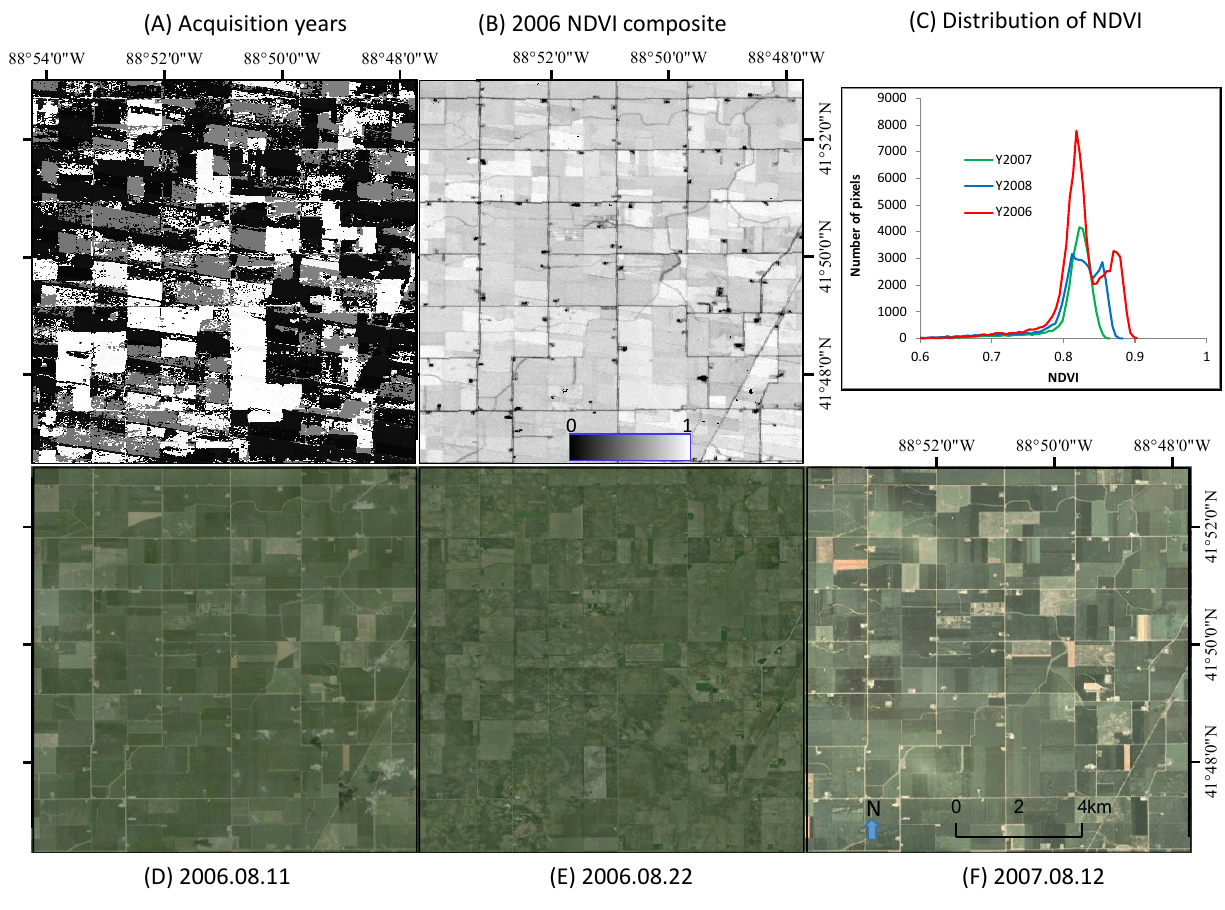
Figure 8. Acquisition years and NDVI values in the 2006 composite in a subregion in the Chicago area. ( A ) Acquisition years: black: 2006, grey: 2007, and white: 2008; ( B ) NDVI values increase from black to white; ( C ) Distribution of NDVI; ( D – F ) Google Earth